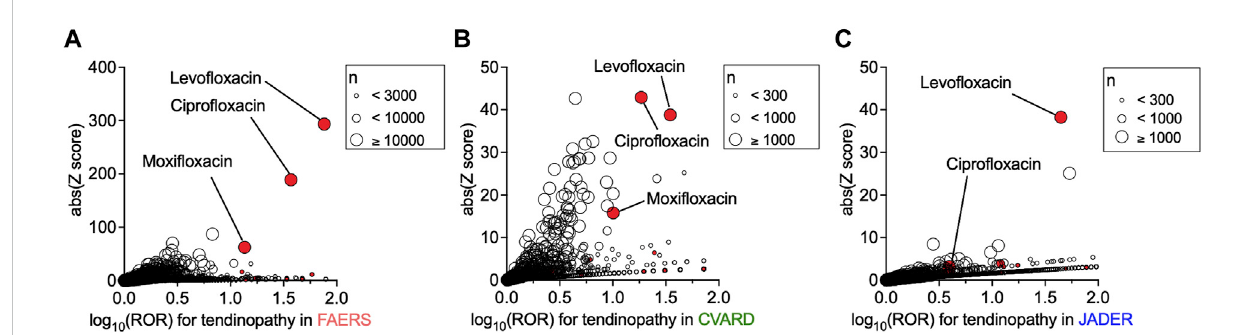
FIGURE 1 Increased incidence of tendinopathy with the prescription of drugs in patients registered in the FDA Adverse Event Reporting System (FAERS), Canada Vigilance Adverse Reaction Online Database (CVARD), and Japanese Adverse Drug Event Report (JADER). The precise equations used in the analyses, all drugs, reporting odds ratio (ROR) values, and Z scores are presented in Supplementary Data S1. Volcano plots of ROR on a log scale and statistical signi fi cance(absolute Z score)are shown. Eachcircleindicatesanindividualdrug,andthesizeofthecircle re fl ectsthenumberofpatients taking the drug. A strong and signi fi cant increase in the ROR of tendinopathy was observed in patients registered in FAERS (A) , CVARD (B) , and JADER (C) taking fl uoroquinolones (red plots), such as levo fl oxacin, cipro fl oxacin, and moxi fl